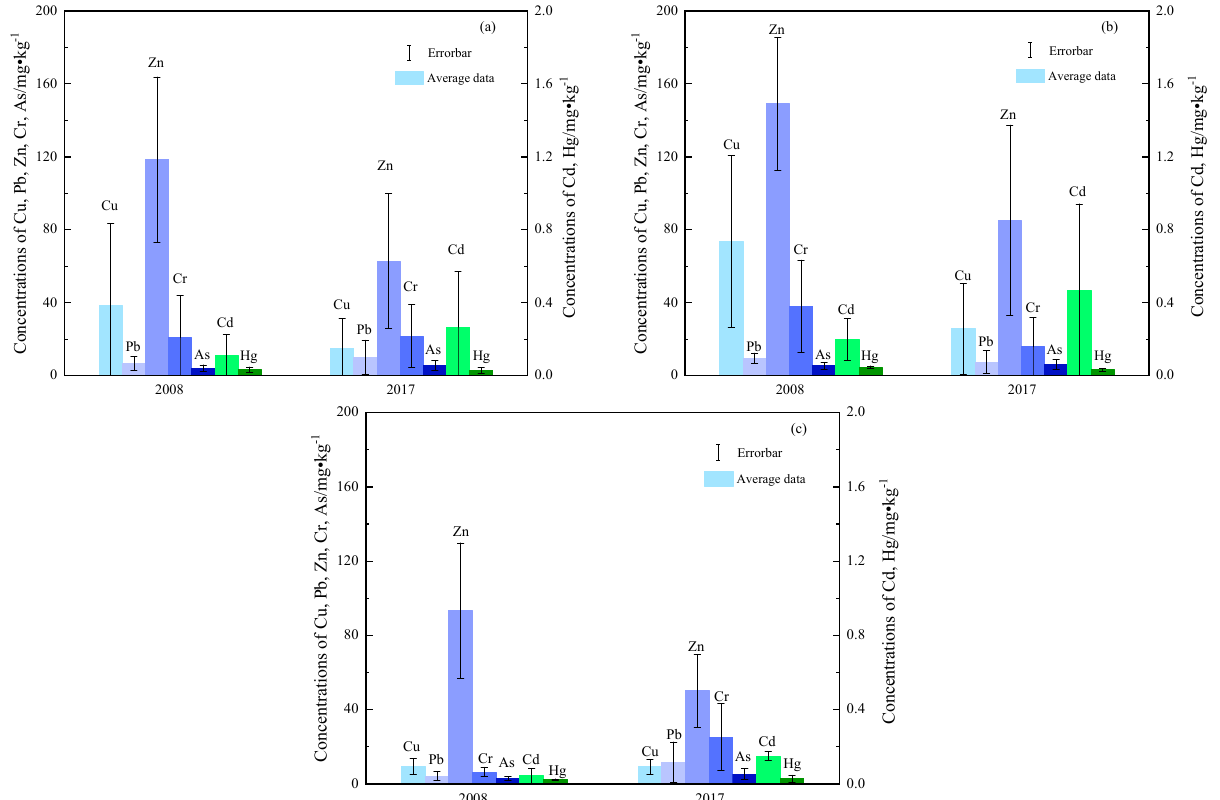
Figure 2. Heavy metal concentrations of the surface sediment from ( a ) the entire Weitou Bay, ( b ) inner Weitou Bay, ( c ) outer Weitou Bay.